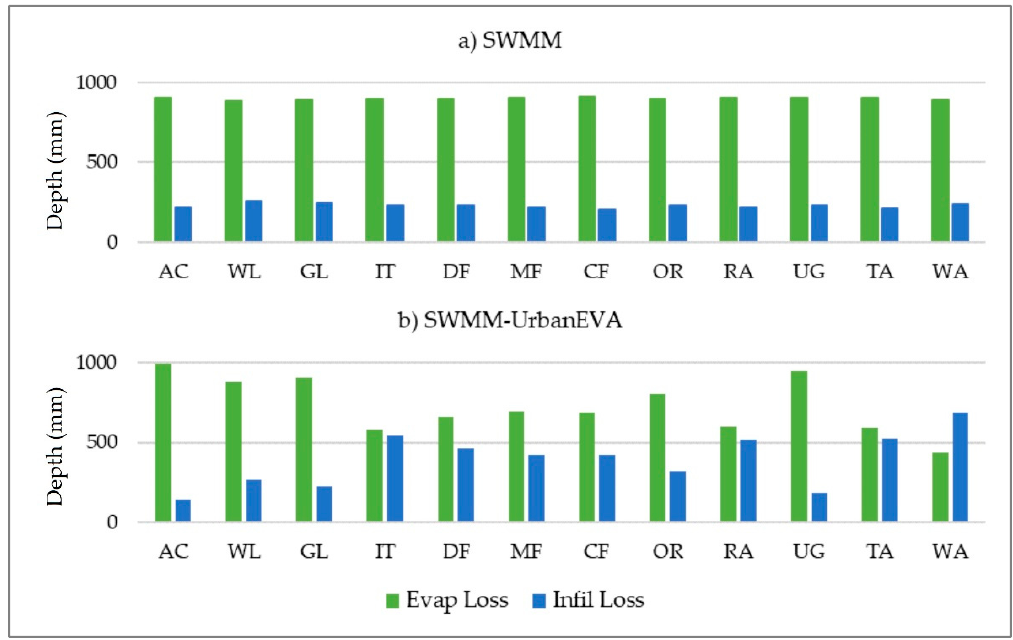
Figure 8. Evapotranspiration and infiltration loss in ( a ) the SWMM and ( b ) the SWMM-UrbanEVA LIDs (pervious area of a subcatchment).